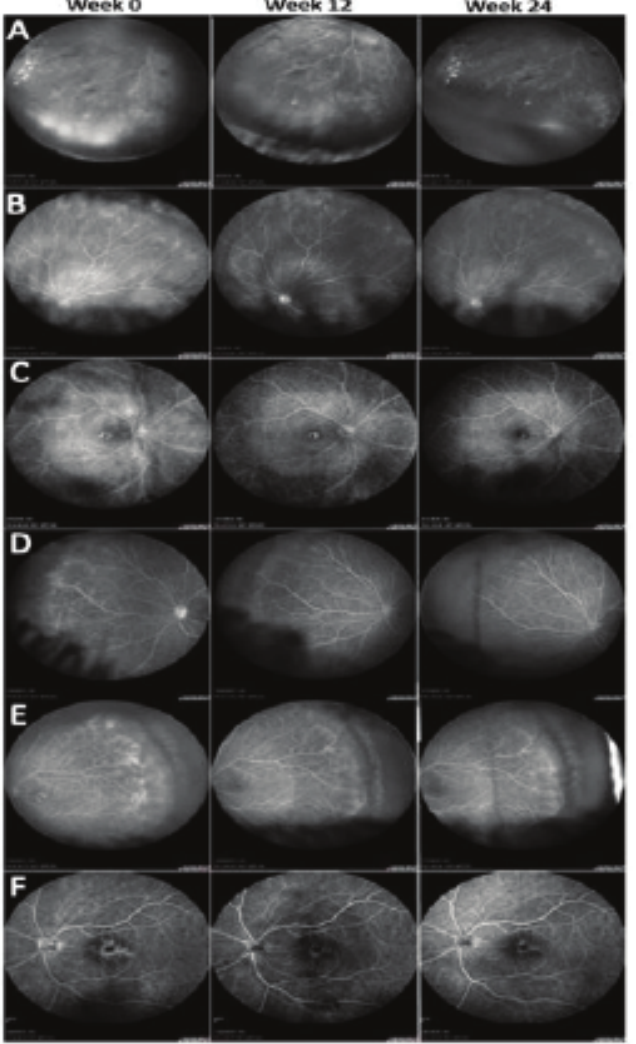
Figure 1. Fluorescein angiography of per protocol study eyes (A–F) demonstrating changes in retinal vasculitis and generalized inflammation from week 0 (baseline) to week 12 to week 24. Of note, varying levels of improvement were seen, from mild to moderate to complete resolution by week